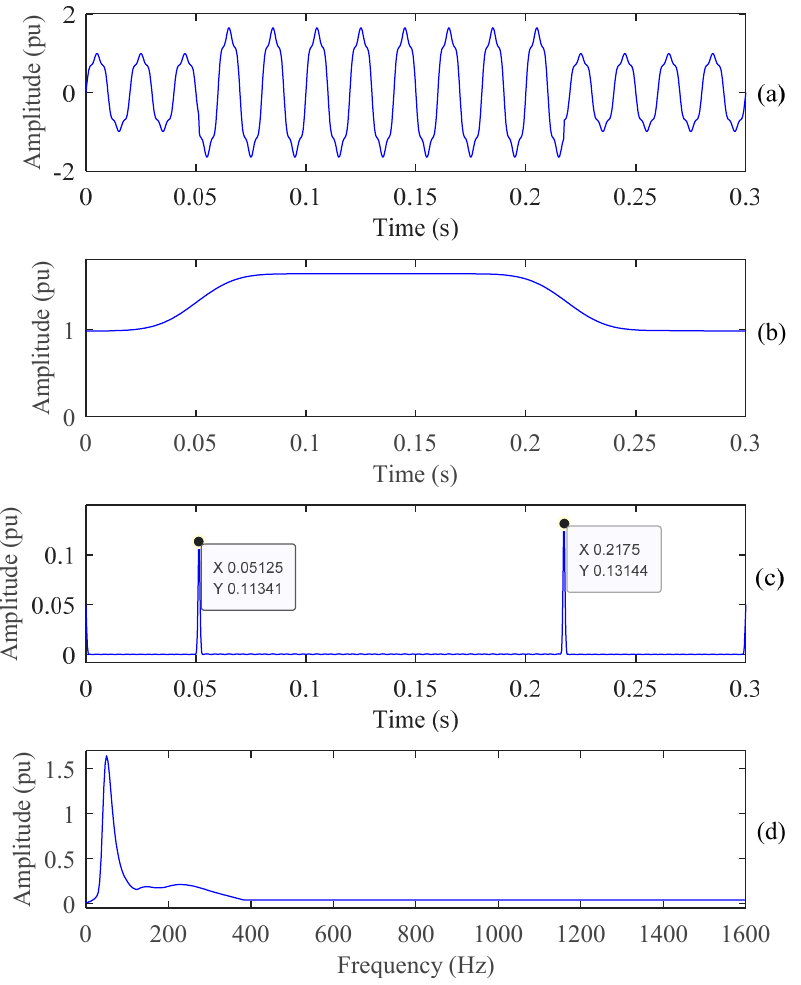
Figure 10. Harmonic voltage swell and related STA : ( a ) Waveform; ( b ) TvA ; ( c ) TvHFA ; ( d ) FvA.